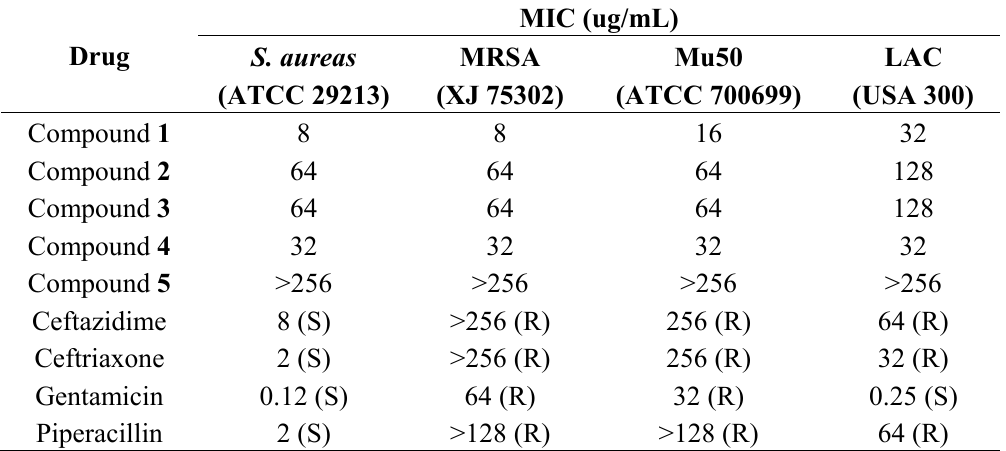
Table 3. MIC of compounds 1 – 5 and antibiotics in Mueller-Hinton Broth